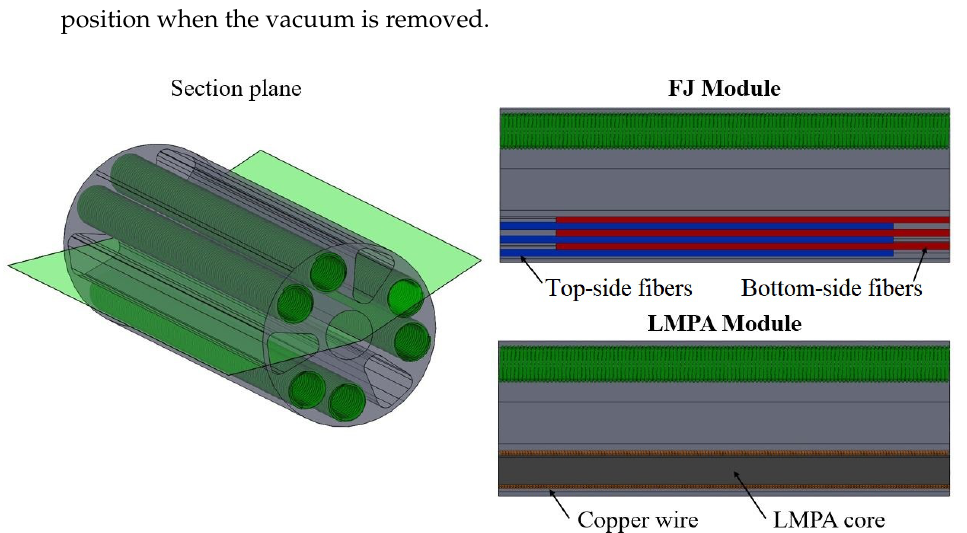
Figure 3. Section views of the manipulator based on the two variable stiffness technologies adopted and compared in this study. Both the central lumen and a pneumatic chamber are also